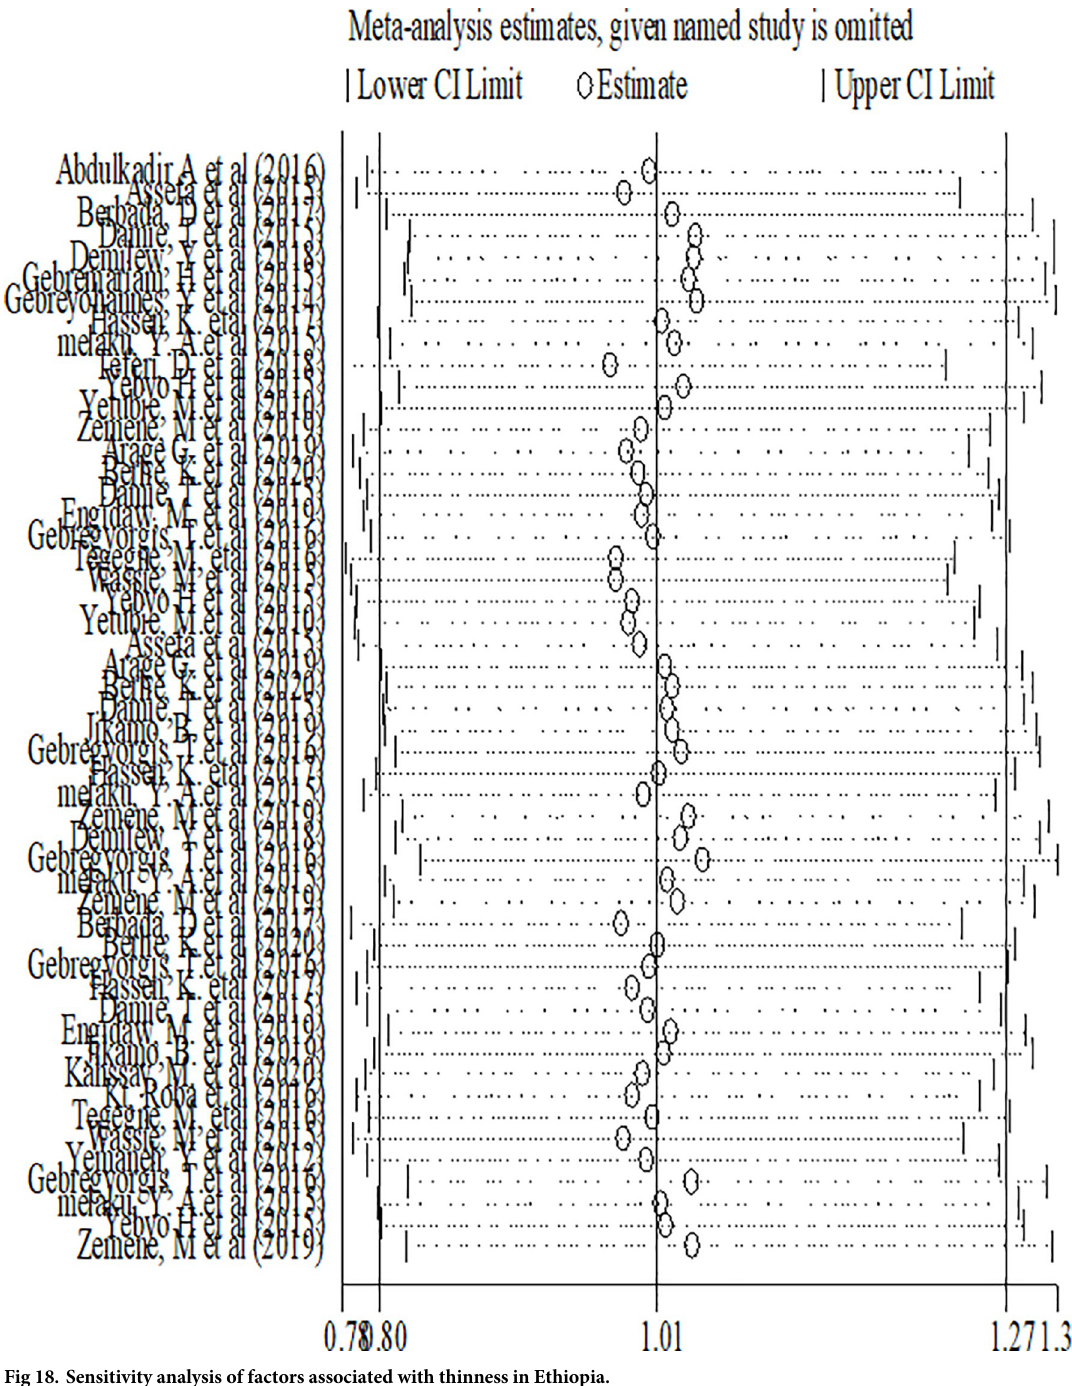
PLOS ONE | https://doi.org/10.1371/journal.pone.0282240 April 12,